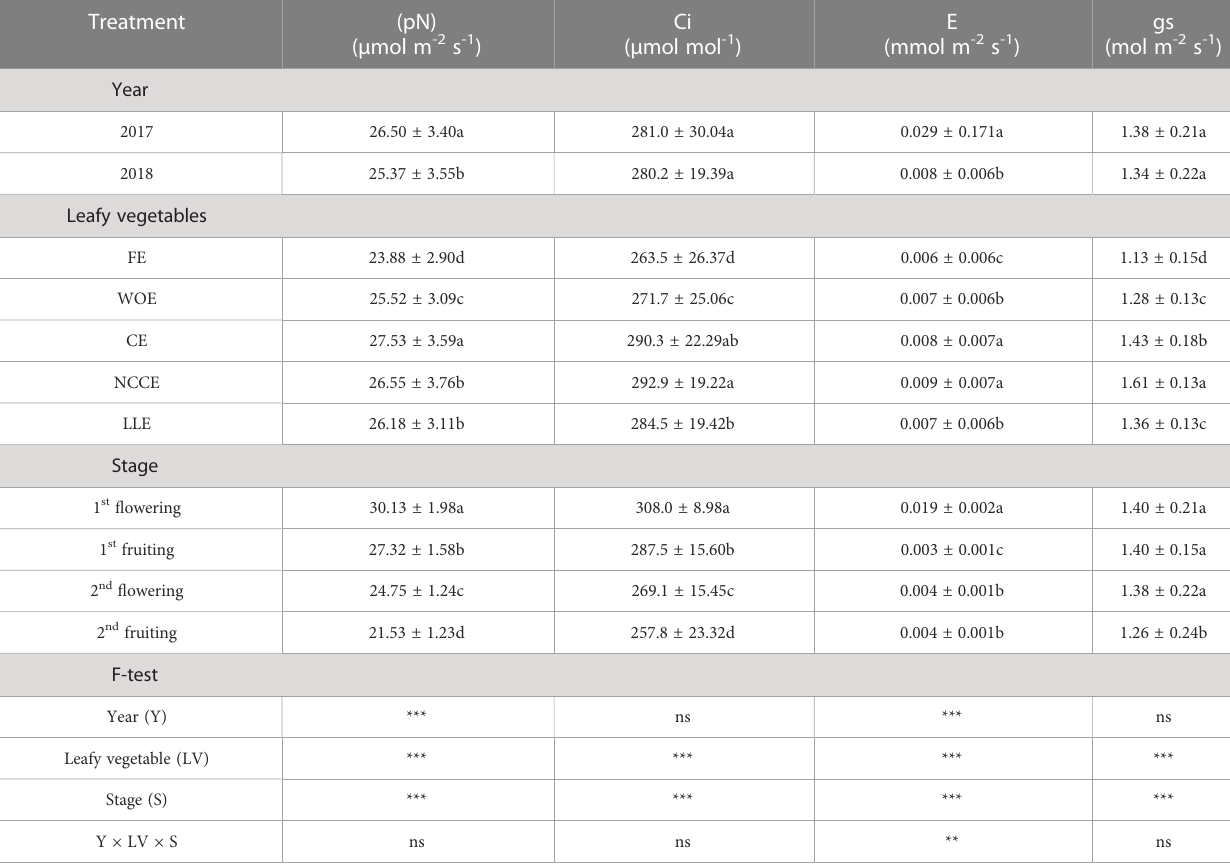
TABLE 2 Effect of different leafy vegetable rotation systems on gas exchange parameters of eggplant at different growth stages during the year 2017 and 2018.